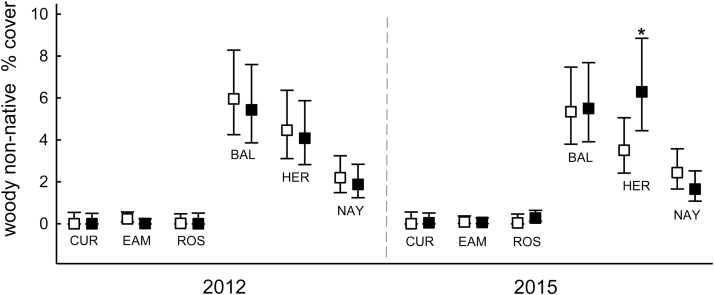
Fall cover (%) of woody non-native species in the herb layer within six suburban forests in central New Jersey, in fenced plots (filled symbols) or in plots with deer access (open symbols). Data are combined across the Microstegium vimineum seed addition and no-addition plots, and are means ± 95 % CI (back-transformed from logits) of 16–20 plots. Asterisks above the mean indicate significant differences in a forest within a year (Tukey–Kramer adjusted P < 0.05).